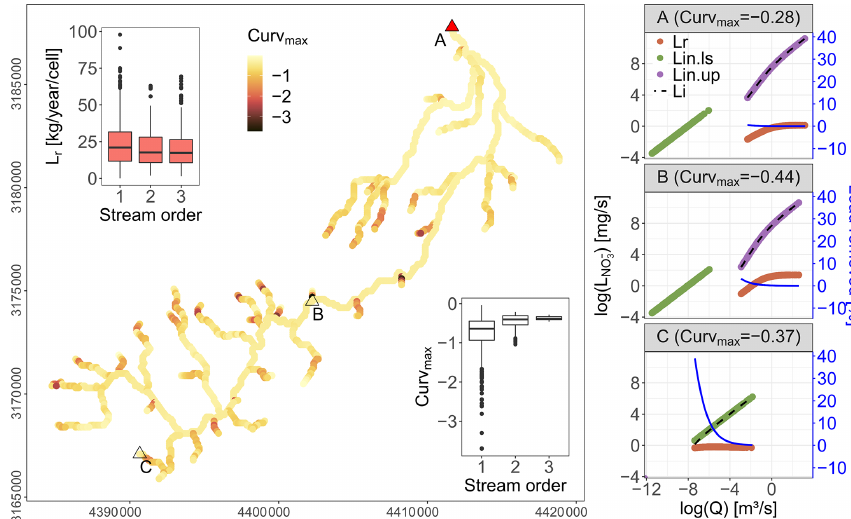
Figure 3. Spatial distribution of simulated Curv max in the Selke river network (Meisdorf) for a selected parameter set (see Table C1). Three representative grid cells covering low (A), intermediate (B) and high (C) total drainage areas show the incoming land-to-stream load as L in.ls (Eq. 3), the incoming load from upstream as L in.up (Eq. 3), the absolute removed load as L r (Eq. 5) and the outgoing load as L i (Eq. 4) in the log (L) –log (Q) space. The load removed as a percentage of the incoming load is presented on the secondary axis. Note that the corresponding Curv max values for these grid cells are calculated from the log (C) –log (Q) relationships rather than log (L) –log (Q) . The insets show the distribution of Curv max and L r for each grid cell within a certain stream order. In Fig. 2a the observed and simulated concentrations are compared at point